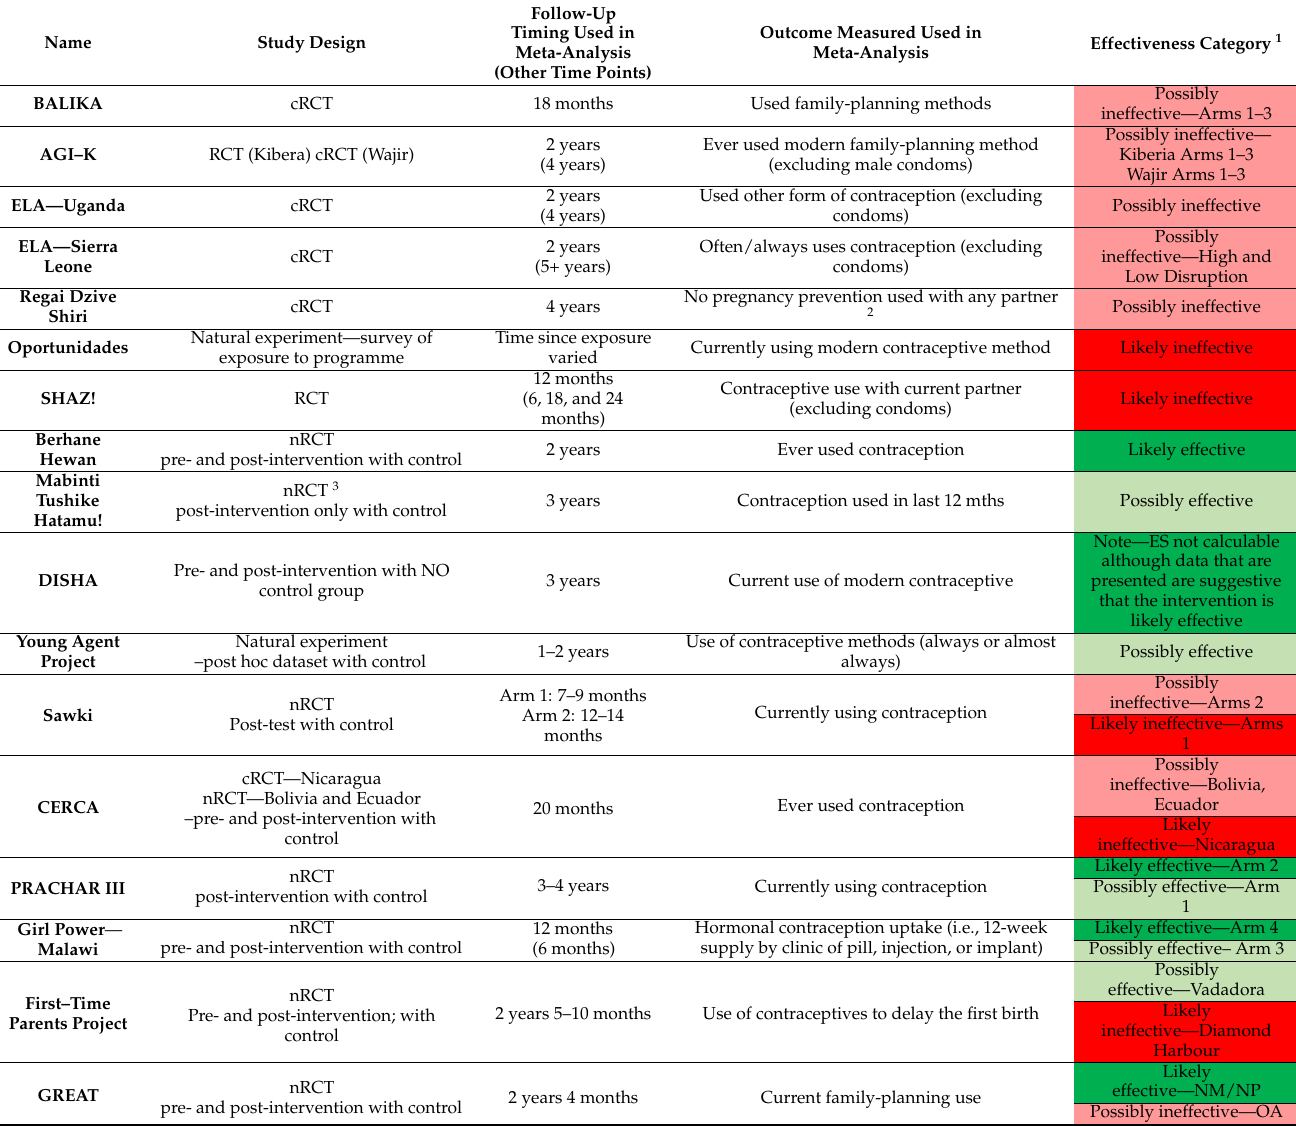
Table A2. Included studies’ outcome evaluation characteristics and